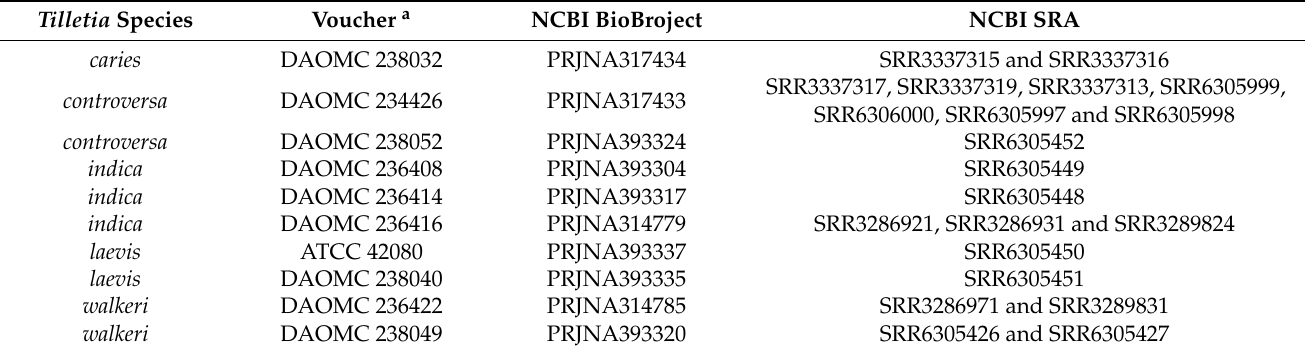
Table 5. Reference genomes used to design qPCR assays. Table adapted from Nguyen et al. [43]. Tilletia